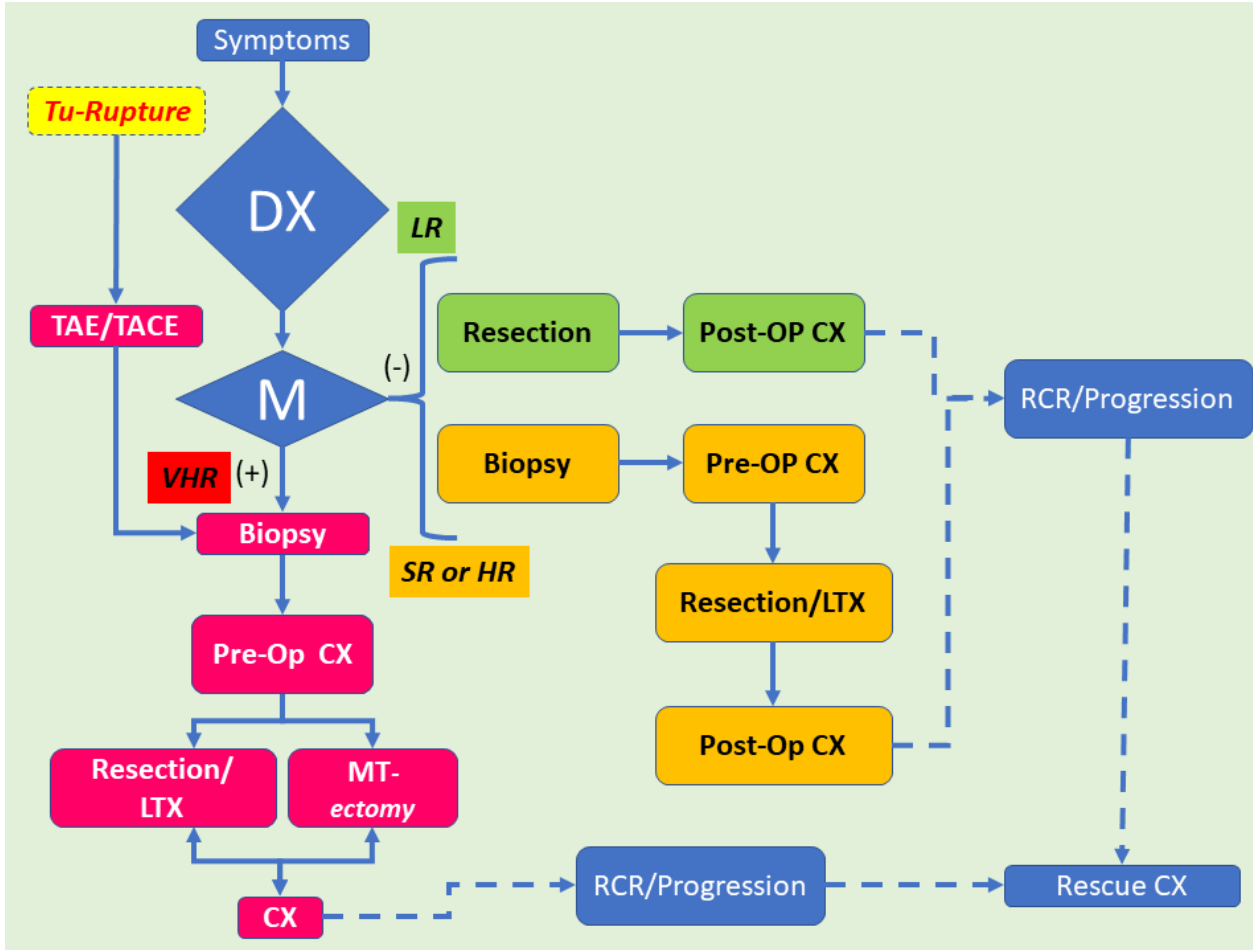
Figure 5. Diagnosis and therapeutic algorithm for hepatoblastoma. Hepatoblastoma is typically diagnosed by objective clinical signs, imaging data, and an increase in serum α -fetoprotein (AFP) levels. In some children affected with hepatoblastoma harboring a tumor, which is identified as ruptured, transarterial embolization (TAE) or transarterial chemoembolization (TACE) is performed to monitor the intraperitoneal hemorrhage. After the hemorrhage is under control, these children should be handled according to the very high-risk stratification flow. Amongst the chil- dren without distant tumor spreading [M(-)], low-risk (LR) children are approached with primary resection followed by chemotherapy in the postoperative period (Post-op CX). Standard-risk (SR) (also known as “intermediate-risk” (IR)) or high-risk (HR) children with HB receive chemotherapy in the preoperative period (Pre-op CX). Then, these patients undergo primary tumor resection by hepatectomy or liver transplantation (LTX). The very high-risk (VHR) patients affected by HB and distant tumor spreading (M(+))receive Pre-op CX. Then, a patient whose distant tumor spreading is reduced by CX goes through primary tumor resection by hepatectomy. Alternatively, these pa- tients may undergo LTX, followed by Post-op CX. However, a patient whose distant tumor spreading remains needs to go through “metastasectomy” or hepatectomy. LTX is typically gener- ally for the patient devoid of distant metastasis. On the other side, LTX may be indicated when distant tumor spreading has obviously vanished. Finally, patients with recurrence (RCR) or neo- plastic progression should undertake some kind of rescue chemotherapy, also known as salvage CX, which is a form of therapy given after a disease does not react to standard therapy. Curative surgery is the primary therapy for all pediatric liver tumors, particularly in the lack of metastatic neoplastic disease. Systemic chemotherapy remains advantageous as metastases are diagnosed in about one-fifth of all pediatric patients. Most children suf- fer from neoplasm recurrence after surgery alone. Clinical data that are provided to the pathologist include: age, α -fetoprotein levels, underlying hepatic disorders, imaging in- vestigational studies (with and without contrast), staging (PRETEXT), maternal and